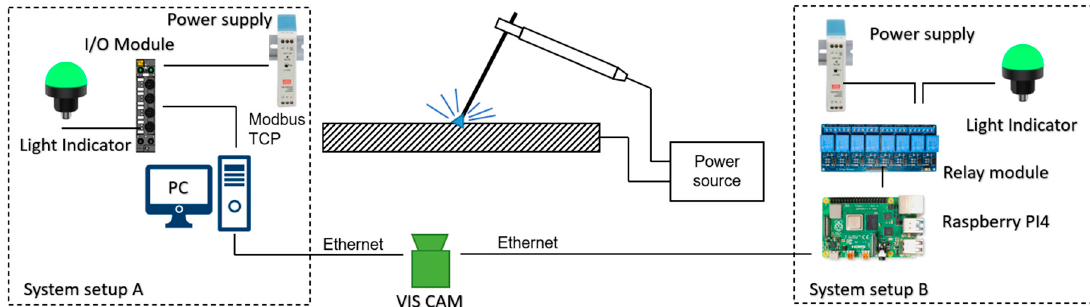
Figure 21. End-user weld monitoring systems setups, with the PC as a central unit (setup A) and a low-cost portable design with Raspberry Pi4 (setup B).